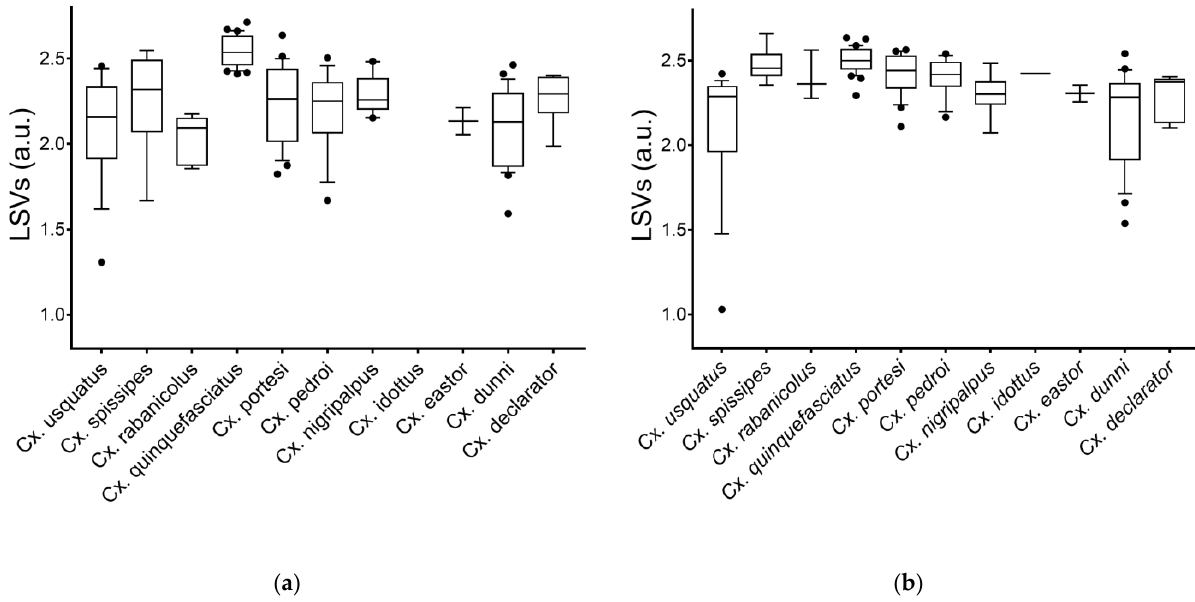
Figure 3. LSVs from query against homemade MS reference database. MS spectra of legs ( a ) and thoraxes ( b ) from Culex mosquitoes are presented. Dashed line represents the threshold value (LSV ≥ 1.8) for relevant identification. a.u., arbitrary units; LSV, log score value.